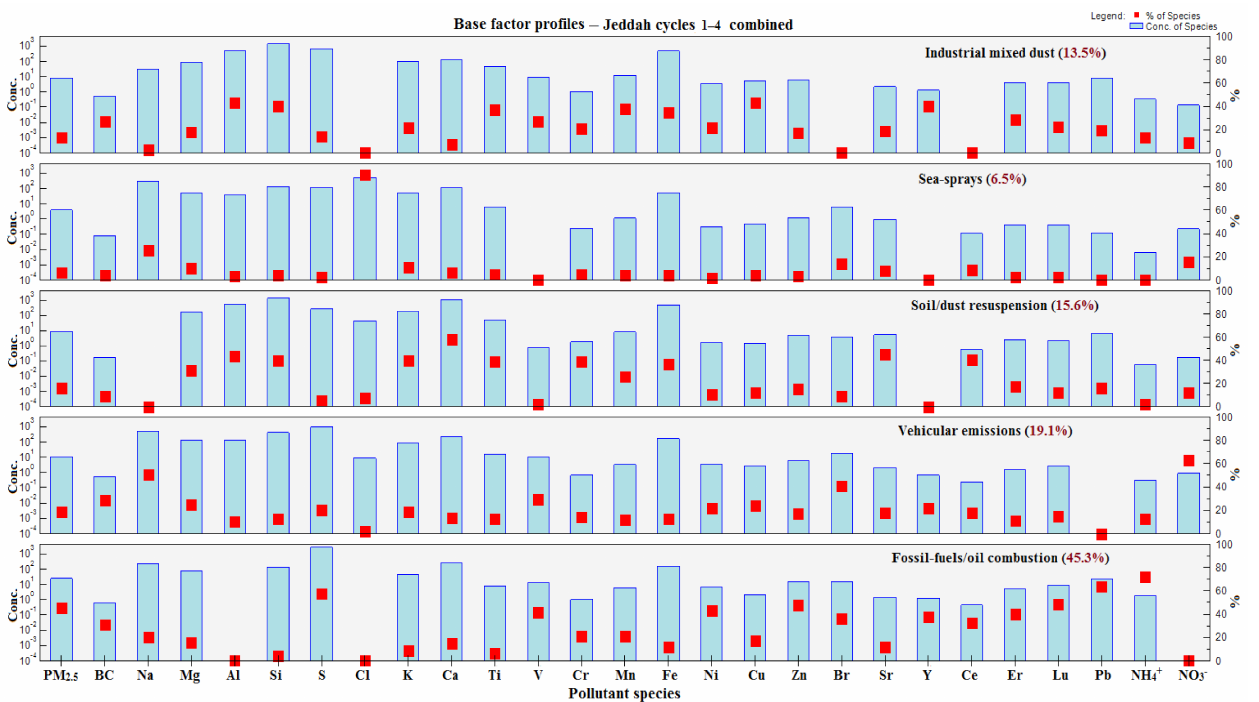
Figure 6. Base factor profiles and contributions to the overall PM 2.5 —all cycles